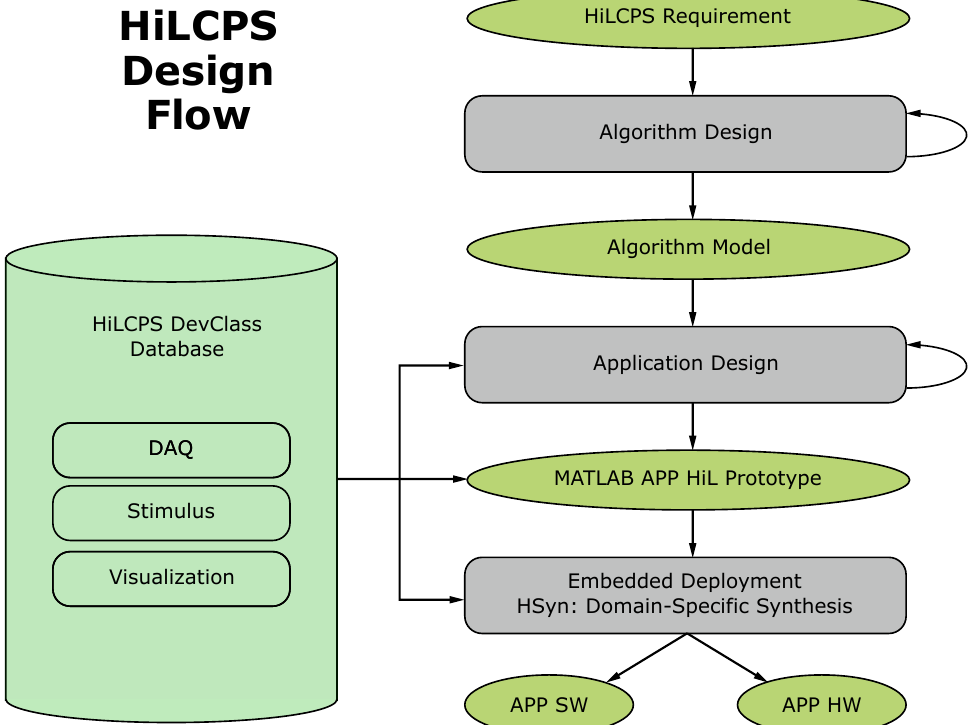
Figure 3. The design workflow when using the HiLCPS framework